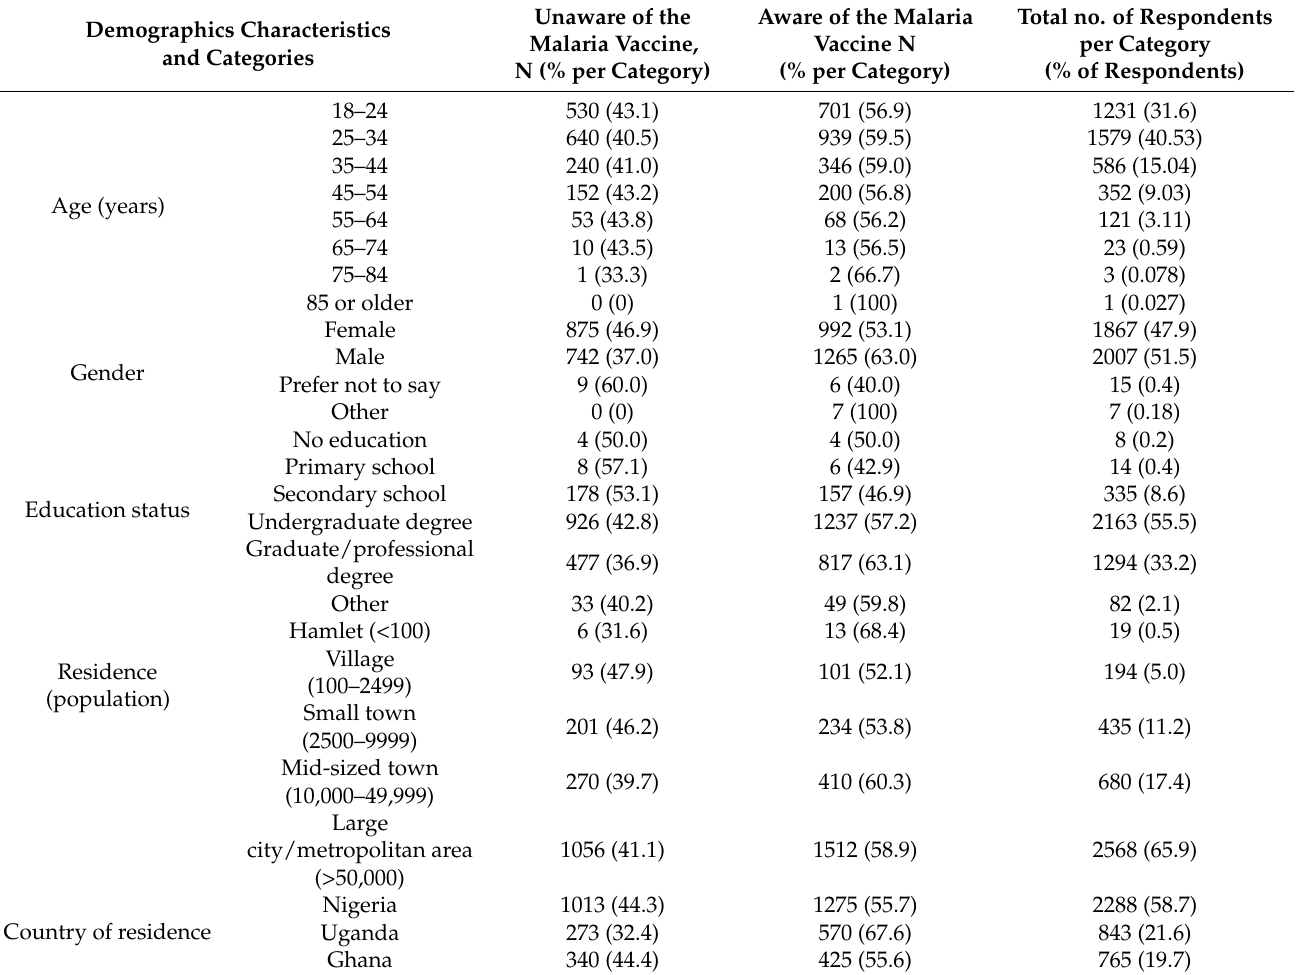
Table 1. Awareness of the malaria vaccine by demographic characteristics and